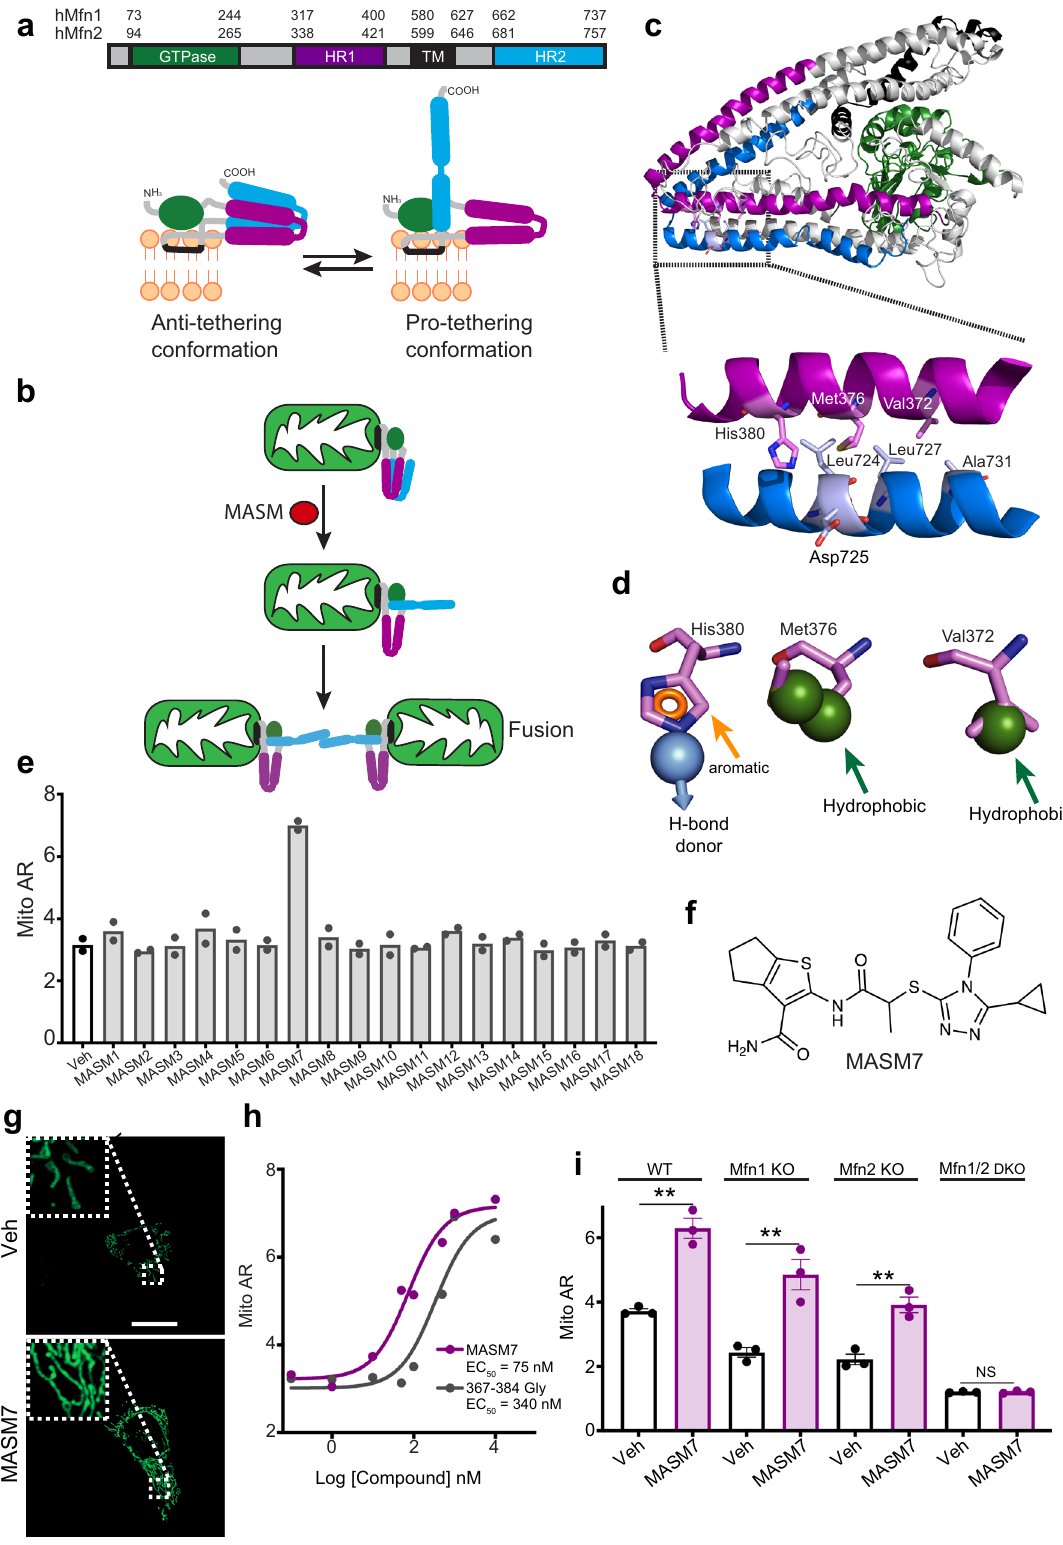
emerged as the most effective compound in promoting mitochondrial fusion (Fig. 1e – g). Interestingly, titration of MASM7 showed more potent induction of mitochondrial fusion in cells than the 367 – 384Gly peptide (Fig. 1h). MASM7 possesses functional groups that ful fi ll the fi ve criteria of the pharmaco- phore model (Supplementary Fig. 3c). To validate this,